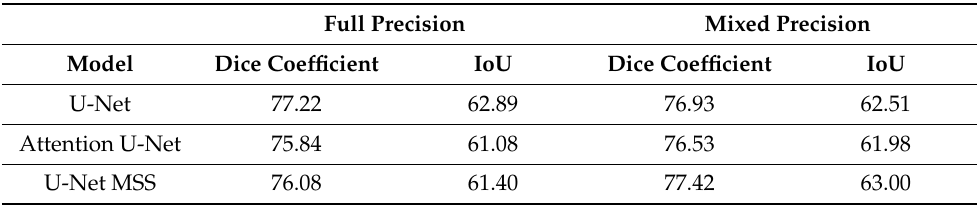
Table A2. Quantitative evaluation of full precision and mixed precision trainings of the baseline